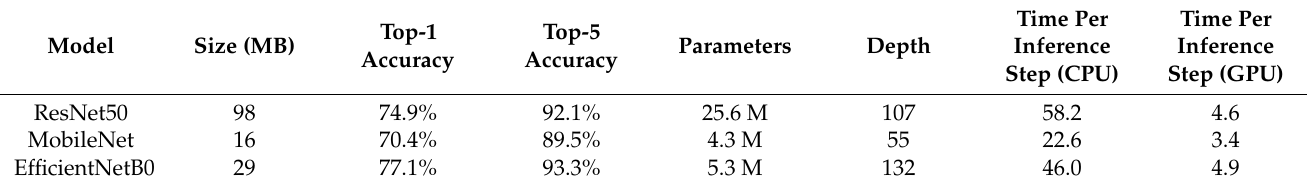
Table 1. Summary of ImageNet